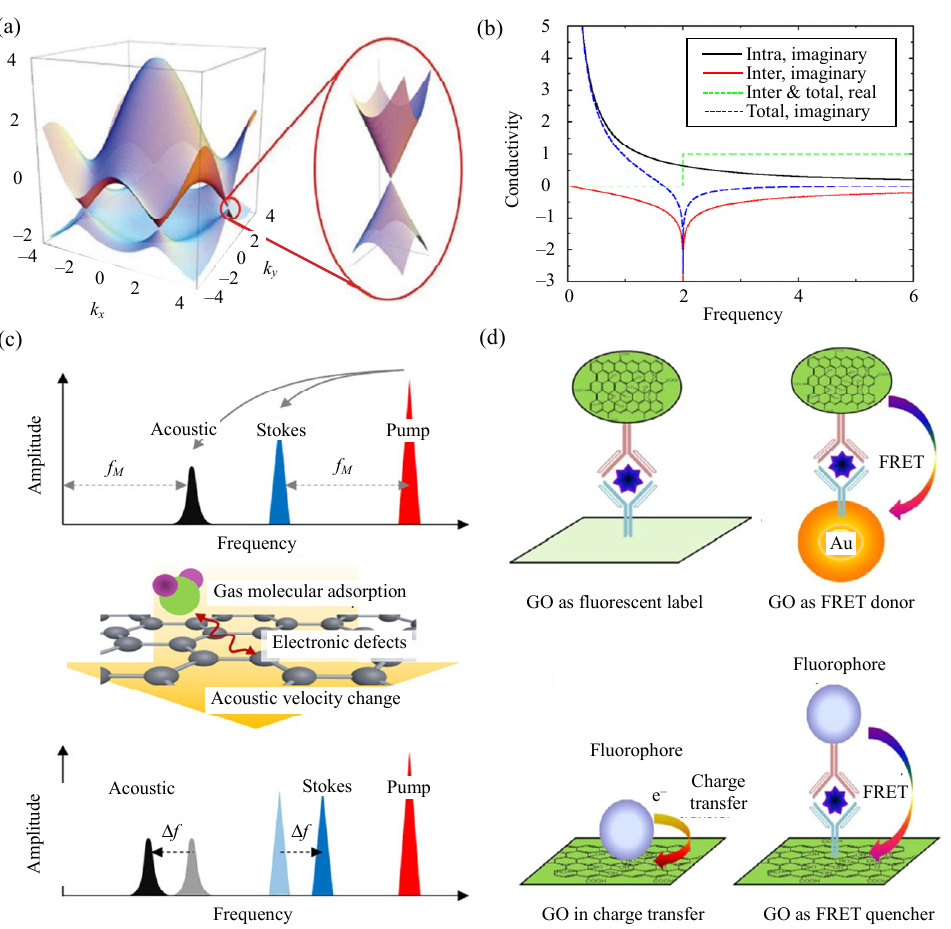
Fig. 1 Graphene sensing mechanism: (a) graphene single-molecule structure and energy band linear distribution [22], (b) dynamic conductivity of graphene for intraband and interband [23], (c) “electron-phonon-photon” process in graphene enhanced Brillouin optomechanical micro resonator [20], and (d) schematic illustration of FRET sensing process based on GO